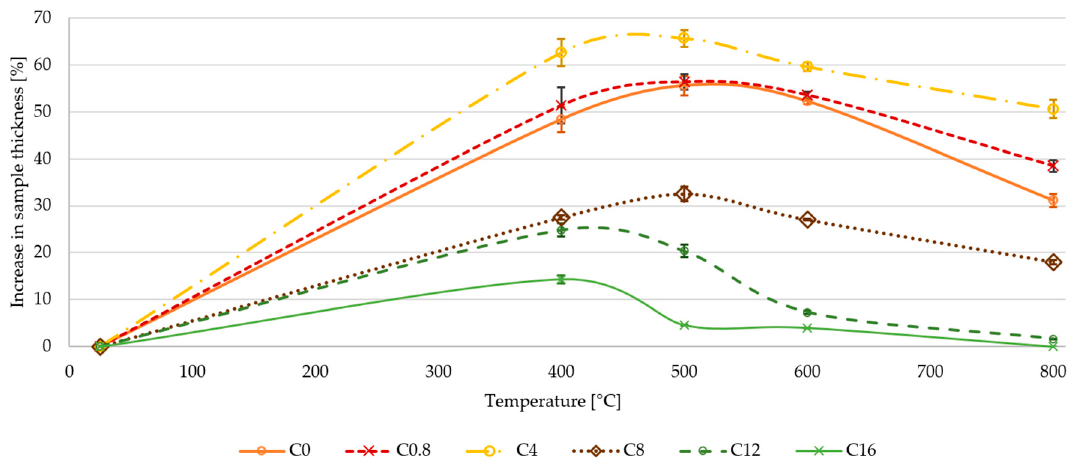
Figure 4. Percentage increase in sample thickness due to matrix swelling.